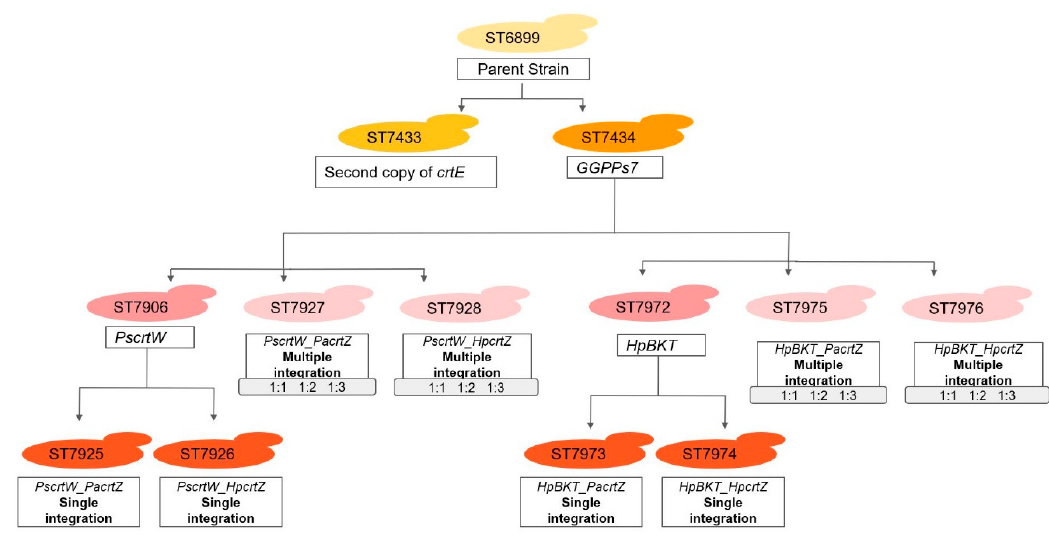
Figure 10. Flowchart of the strains generated in this study. 388